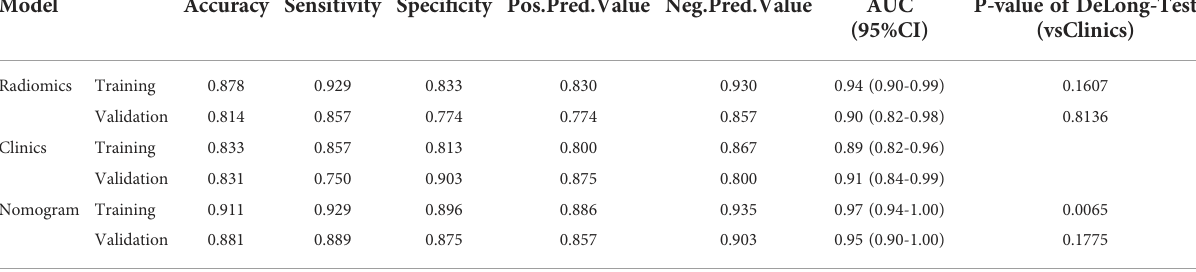
TABLE 2 In the training group and the validation group, a table showing the diagnostic ef fi cacy of radiomic, clinical, and radiomic-clinical joint models. Model